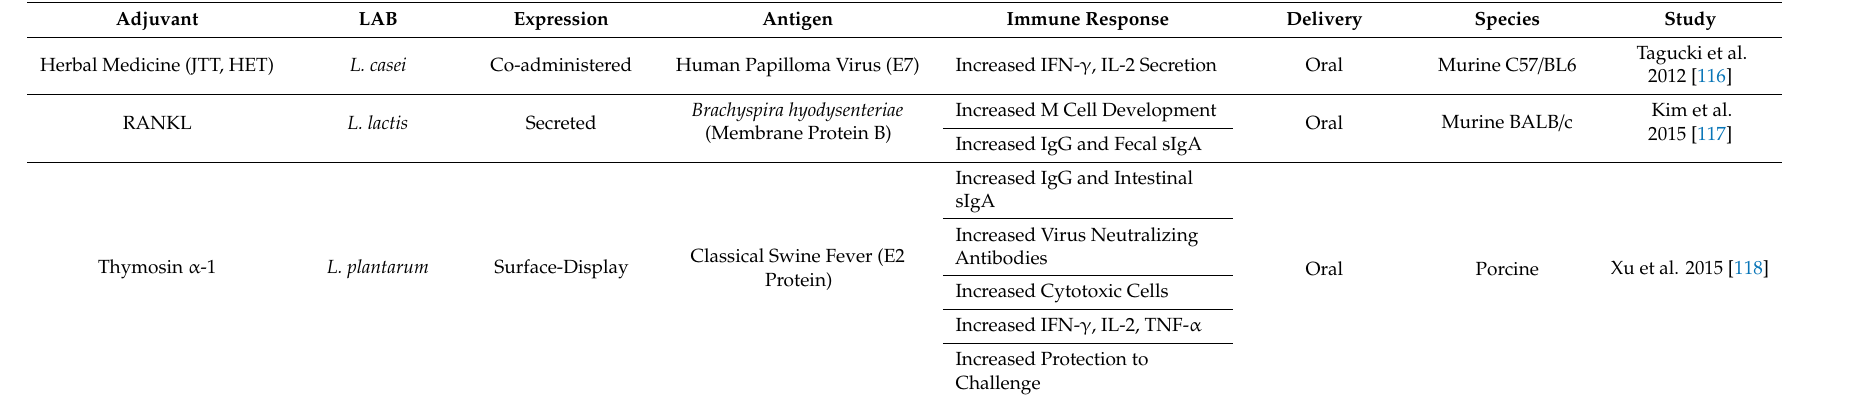
Table 5. Other adjuvant strategies for lactic acid